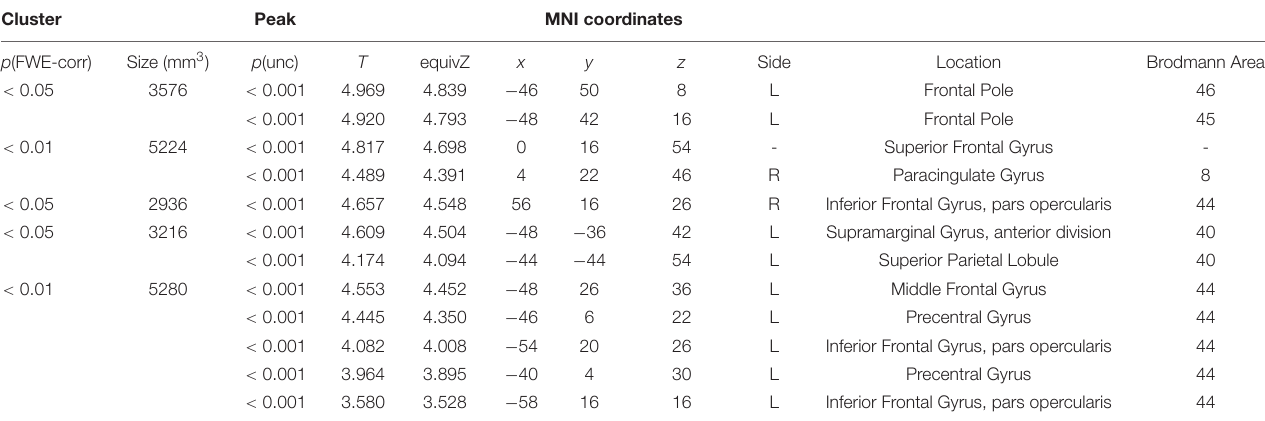
TABLE 3 | The regions showing greater activation in DO compared to PO (nD > nP). Cluster Peak MNI coordinates